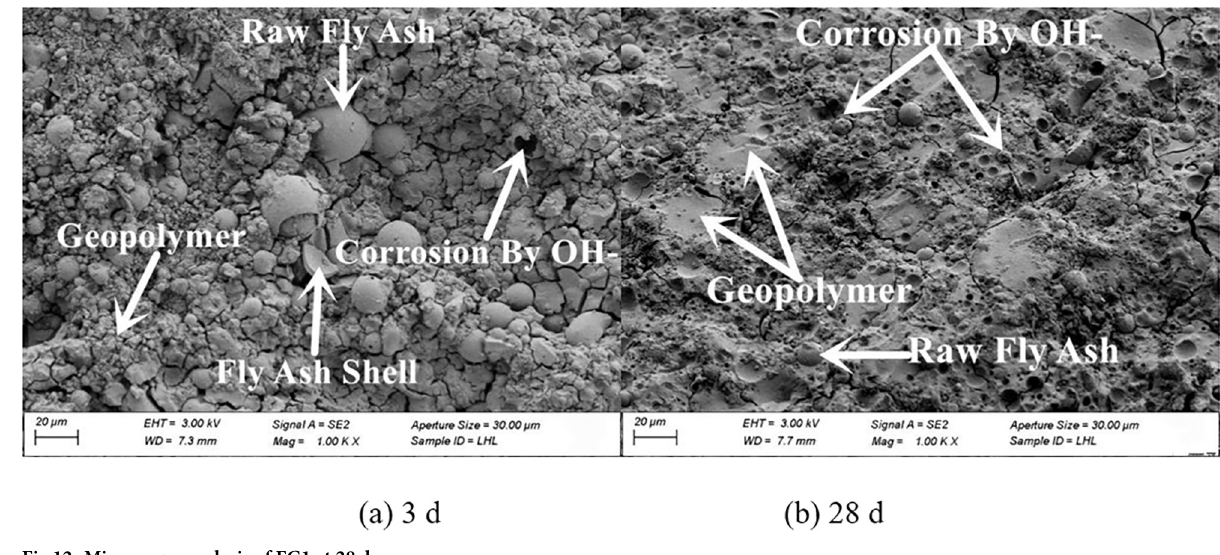
Fig 12. Microscopy analysis of FG1 at 28